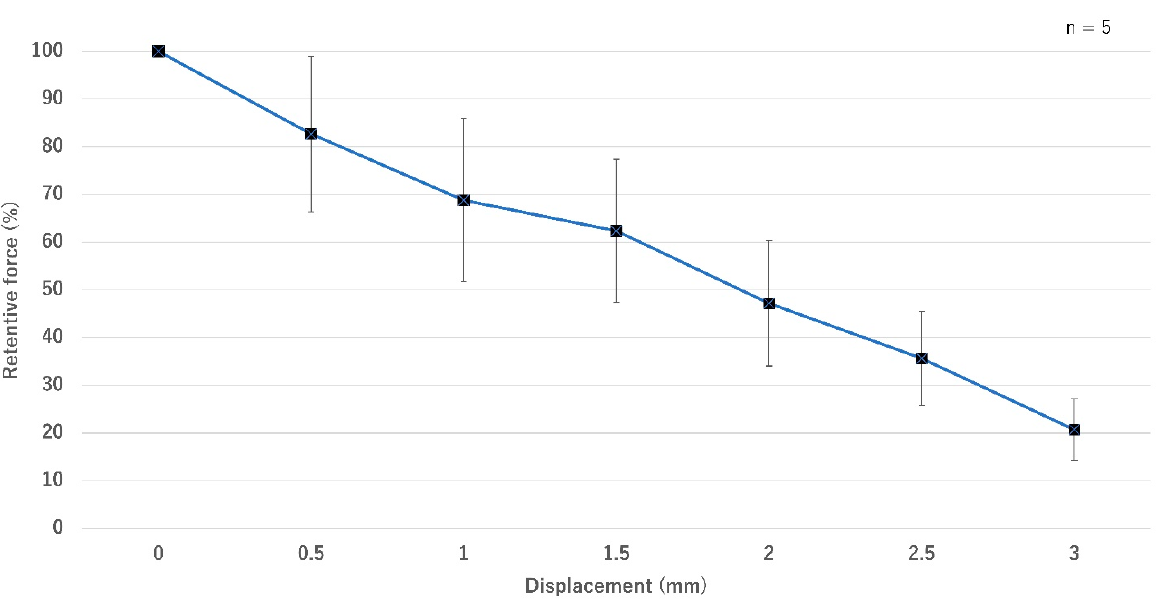
Figure 4. Comparisons of retentive forces at displaced positions (means and standard deviations).